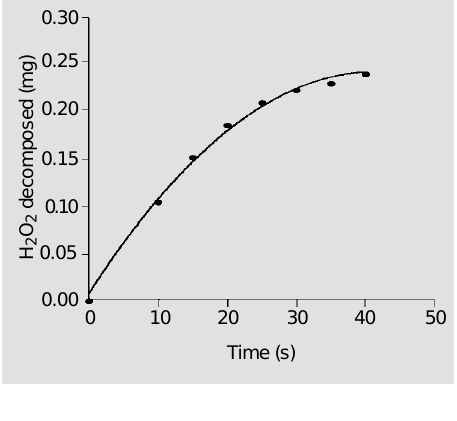
Figure 3 - Correlation between the amount (mg) of hydrogen peroxide decomposed by cata- lase and the square root of time, in seconds. The straight line ob- tained indicates the parabolic be- havior of the data in Figure 2. The equation of the straight line is y = 0.0399x - 0.0029. R 2 = 0.9838.